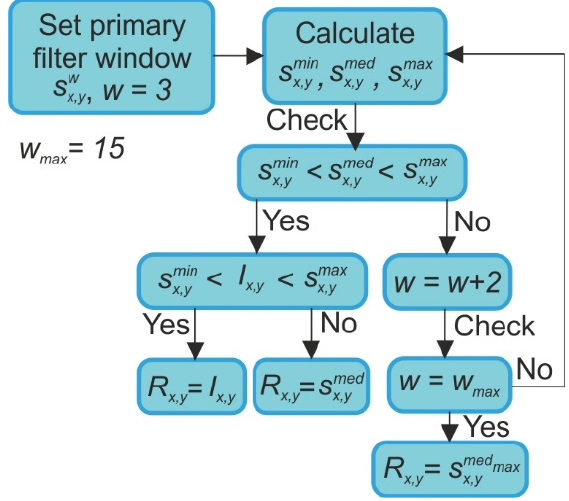
Figure 2. An adaptive median filter by Li and Fan [75]. S min x , y , S med x , y and S max x , y denote, minimum, median and maximum values of the pixel in the filter window S w x , y cantered at ( x , y ) with a window of size w ; w max —maximum filter window; I x , y —primary value of pixel; R x , y —value of filtered pixel; S med max x , y —median value within w max . Primary filter window w is set to 3 × 3 pixels and w max to 15 × 15. If it is determined that the pixel is not contaminated with noise within the 3 × 3 window, the primary pixel value is preserved. If the pixel is contaminated with noise, the filtering window is increased by 2 pixels. The procedure is repeated until the maximum window is